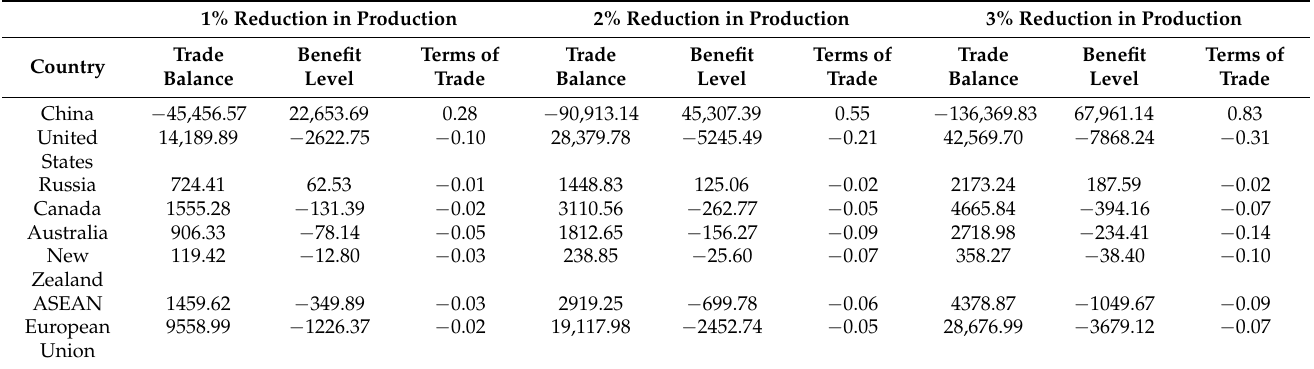
Table 6. Impact of changes in production on welfare and trade across countries. 1% Reduction in